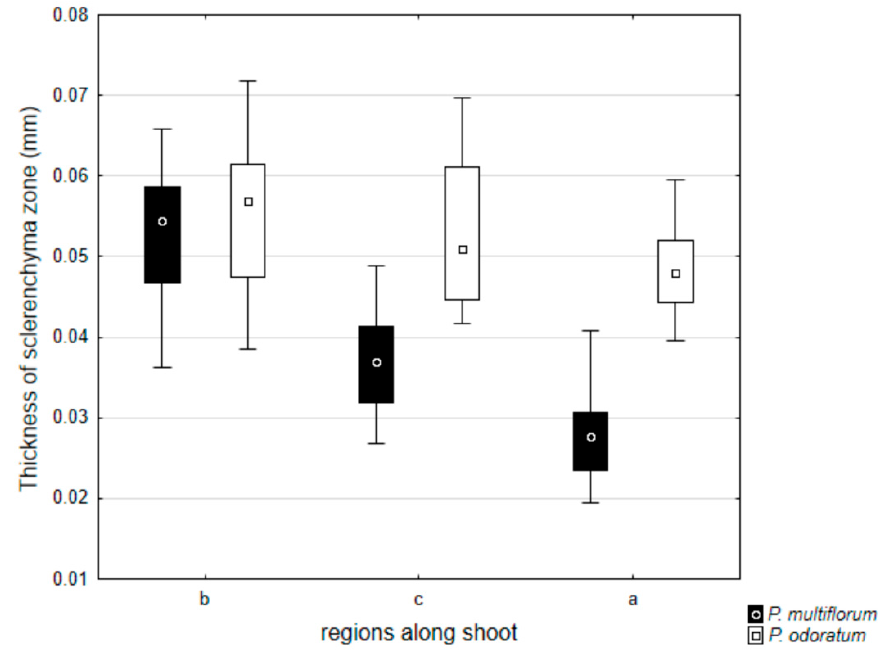
Figure 4. Thickness of sclerenchyma zone at basal (b), central (c) and apical (a) regions along shoot of both species. Significant differences are for central ( p <0.0001) and apical ( p <0.0000001) regions.